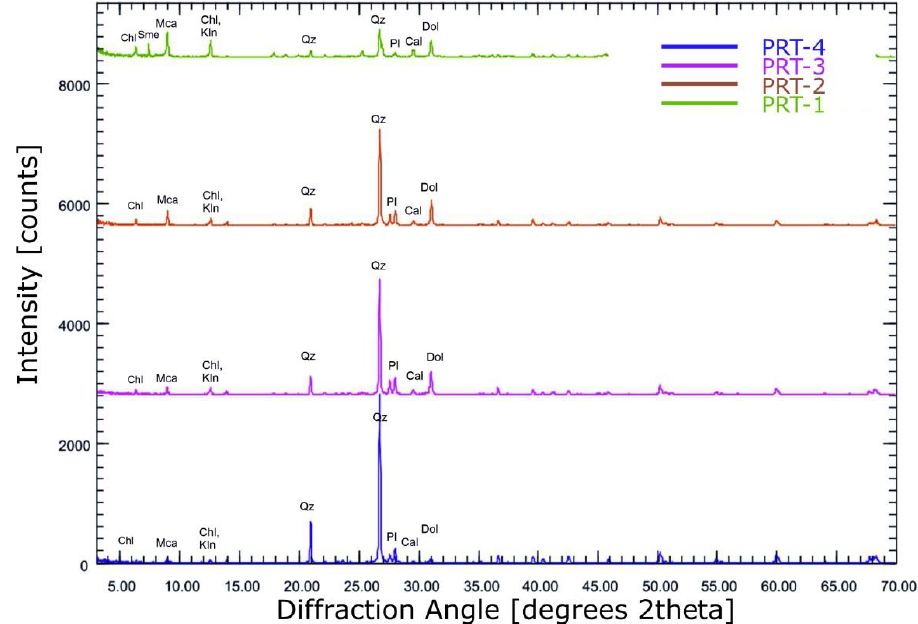
Figure 13. XRD patterns of four Upper Pannonian sandstone samples based on Petrophysical Rock Typing (PRT). Sample numbers correspond to relevant PRT group number. Chl—chlorite; Sme— smectite; Kln—kaolinite; Mca—mica; Qz—quartz; Pl—plagioclase; Cal—calcite; Dol—dolomite. The